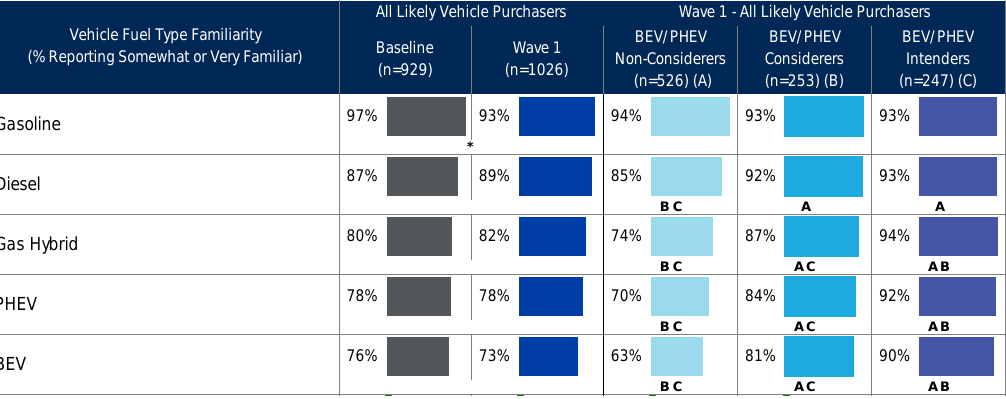
Figure 2. Respondent familiarity with vehicle fuel types, by survey wave and segment (multiple responses allowed). Note: Letters A–C indicate statistically significant differences between likely vehicle purchaser segments (z-test for proportions, p < 0.05). * Indicates a statistically significant difference between Baseline and Wave 1 survey’s all likely vehicle purchasers (z-test for proportions, p < 0.05).